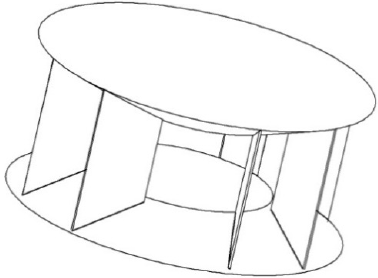
Figure 2. Three ‐ dimensional model of the ODGV.